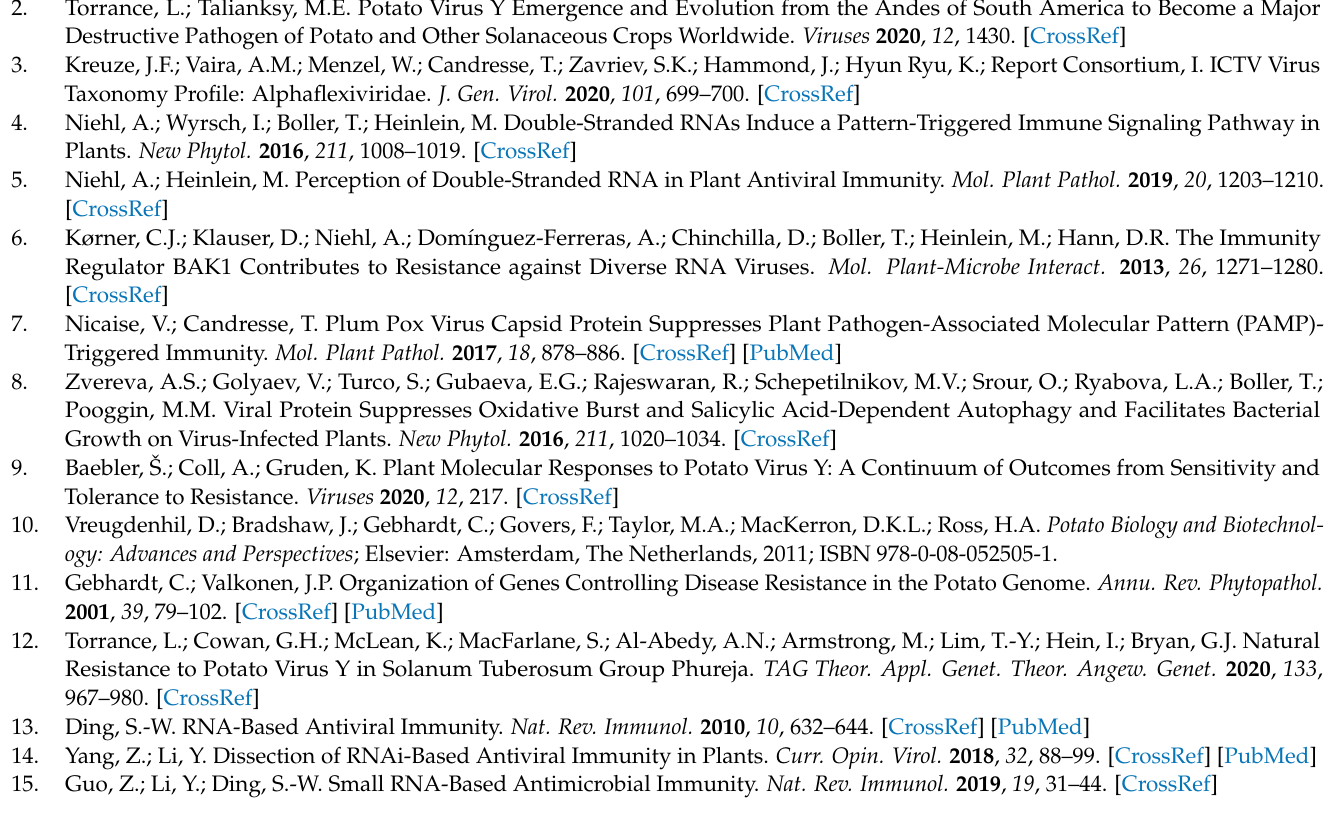
genes; Table S4: g:Profiler enrichment results, showing GO and KEGG terms enriched among differentially expressed genes; Table S5: Cluster IDs and annotation for differentially expressed genes; Table S6: g:Profiler enrichment results, showing GO and KEGG terms enriched in gene clusters from Figure 3; Table S7: Log 2 FC values of differentially expressed lncRNAs; Table S8: Log 2 FC expression values of differentially expressed antisense lncRNAs and corresponding mRNAs; Table S9: Table showing lncRNAs with miRNA target sites and the IDs of the miRNAs; Table S10: Isoforms with significant changes in ratio between Mock, 22 ◦ C and PVY, 28 ◦ C, and their functional annotation; Table S11: Results of RNA methylation analysis with m6Anet for virus Y sequence and xPore for mRNAs. Table S12: Primers used for quantitative RT